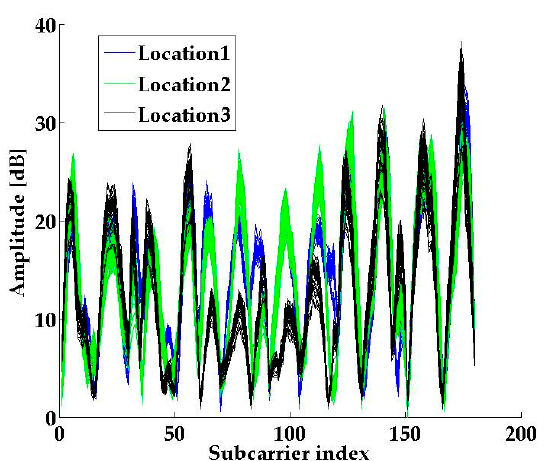
Figure 4. CSI amplitude from three different locations.